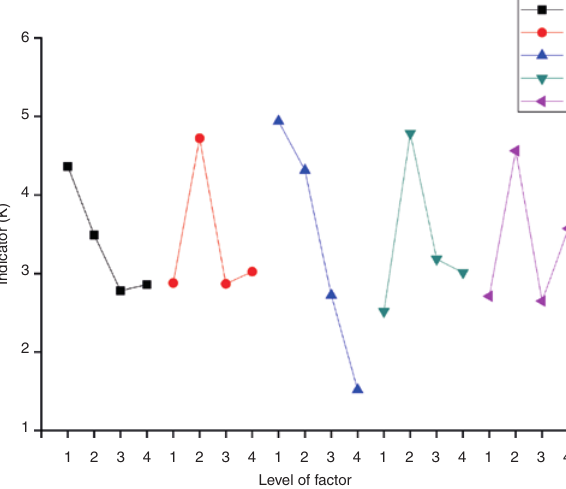
Figure 9: The relationship of factor level and